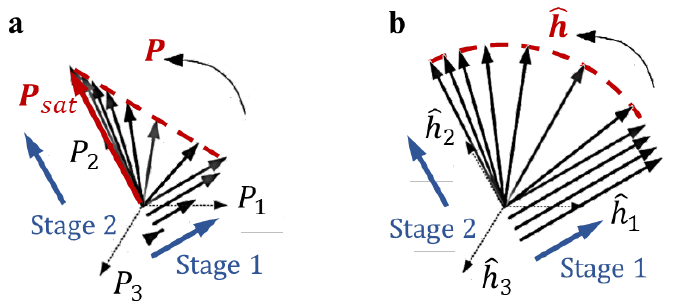
Figure 6. Evolution of the tensor variables ( a ) P and ( b ) ˆ h used in the M á nik–Holmedal–Hopperstad and homogeneous anisotropic hardening models in a two-stage loading process. Reprinted with permission from Ref. [69]. 2017, Qin, J. et al.